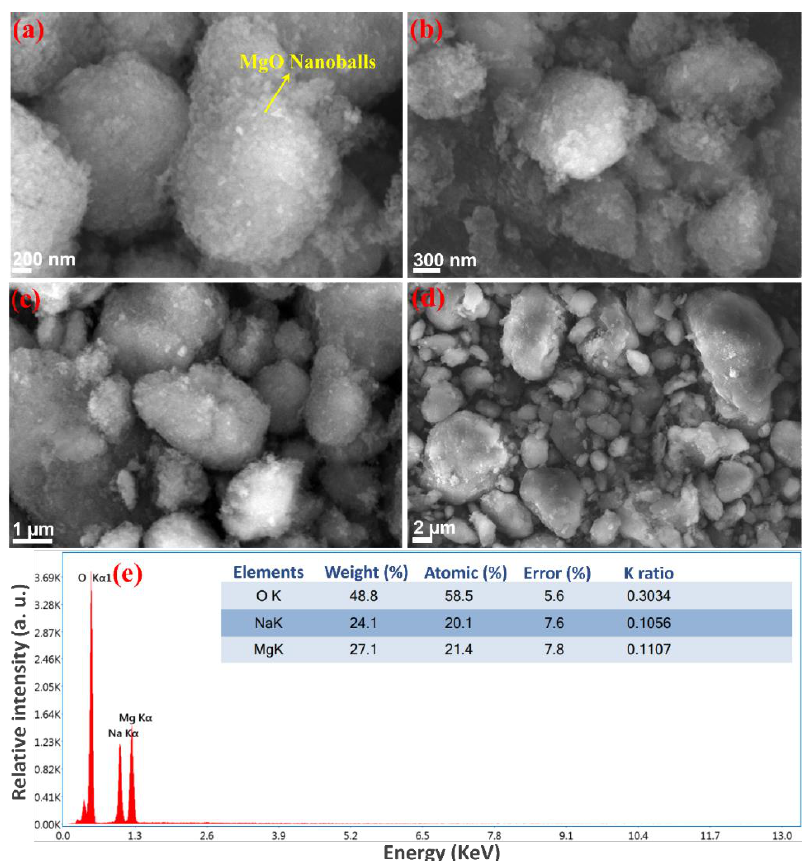
Figure 3. SEM images at different magnifications ( a – d ) and EDX spectrum ( e ) of MgO NBs.